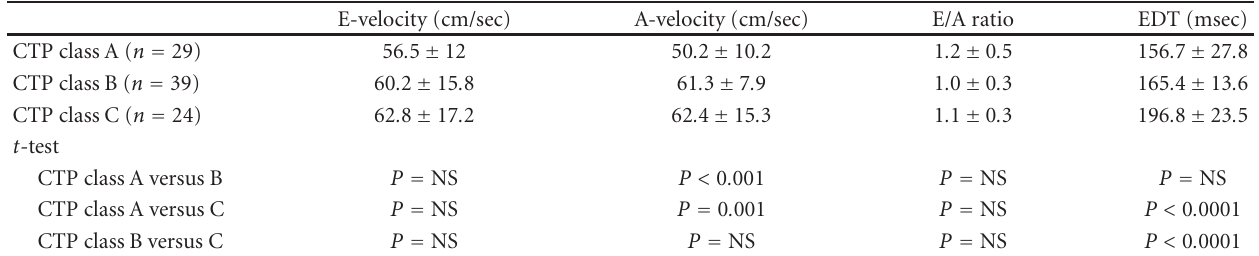
Table 2: Comparative assessment of left ventricular diastolic filling indices with regard to severity of liver